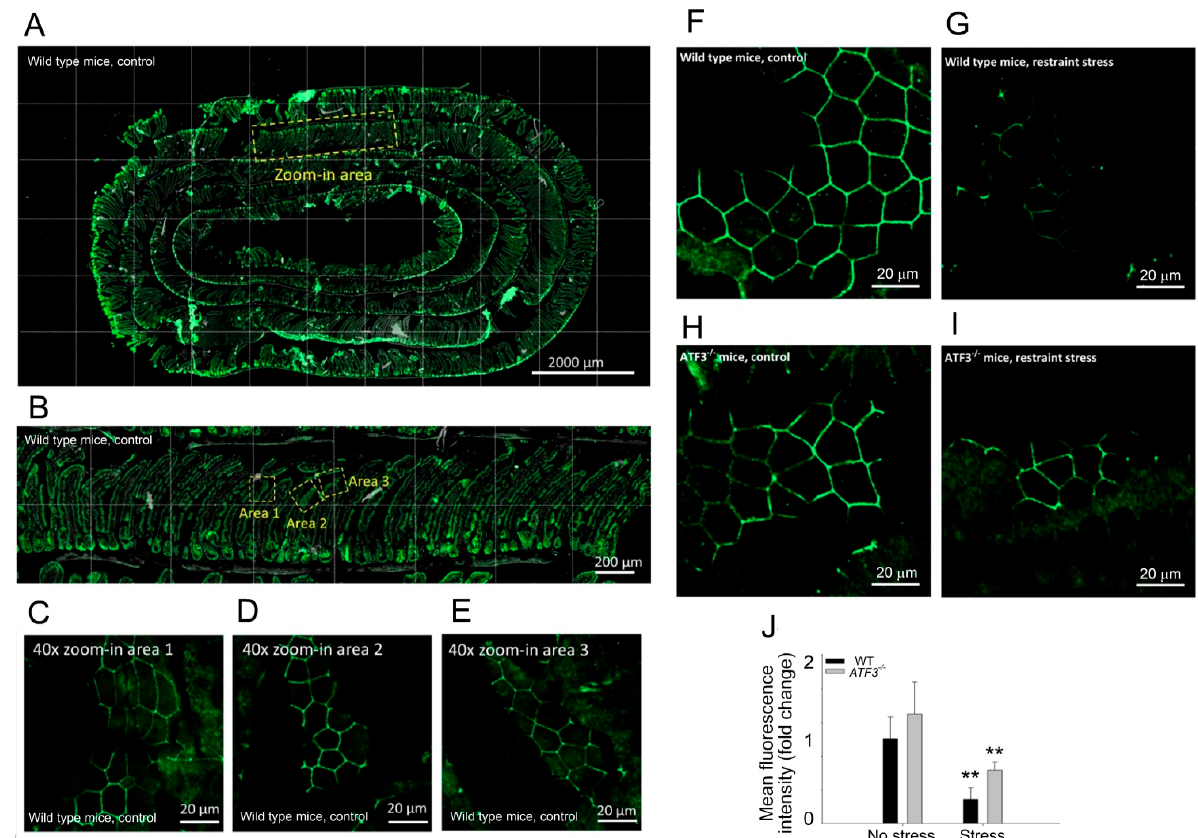
Figure 7. Confocal microscopy of immunohistochemistry (IHC) CLDN3 staining. Tissue section IHC of a Swiss-rolled duodenal sample was stained with a fluorescence-labeled anti-CLDN3 antibody. ( A ) A representative image at low magnification is presented. ( B ) The yellow boxed zoomed-in area in ( A ) is enlarged as a higher magnification view. ( C – E ) Areas 1, 2, and 3 in ( B ) are further enlarged to observe the detailed expression patterns of CLDN3 in the villi of the duodenal tissue. ( F – I ) The CLDN3 staining in the WT mice ( F , G ) was compared to ATF3 − / − mutants ( H , I ) without ( F , H ) or with ( G , I ) restraint stress. ( J ) The quantitative results are obtained from 3 images at various areas; ** p < 0.01 vs. the respective no stress groups. ( J ) The averaged mean fluorescence intensity of the WT no stress groups was normalized to 1-fold. ( A – G ) WT mice and ( H , I ) ATF3 − / − mutants. Scale bars: 2000 µ m ( A ), 200 µ m ( B ), and 20 µ m ( C – I ). Error bars show the standard